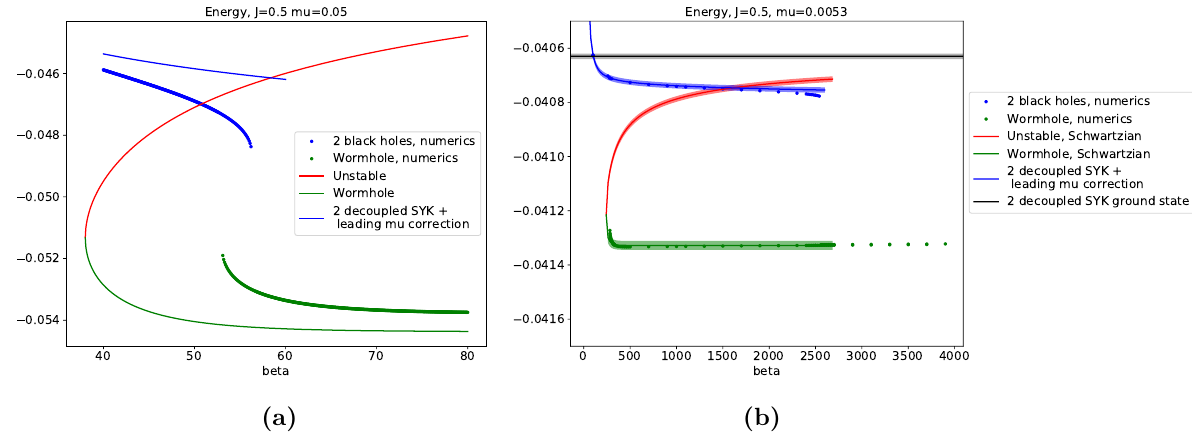
Figure 6 . Thermodynamics of the model for two different values of µ/J . In both J = 0 . 5 and in (a) µ = 0 . 05 and in (b) µ = 0 . 0053 . The dots correspond to numerical solutions of the SD equation. The blue ones for the two black hole phase and the green ones for the cold wormhole phase. The black line is the ground state energy of two decoupled SYK, 2 E (on the left plot it lies above 0 ,SY K the visible area). Blue curve: the perturbative result (2.19) for the energy. Green curve: wormhole branch of eq. (2.32). Red curve: unstable branch of eq. (2.32). The uncertainties, represented as shaded regions, come from the uncertainties in E and α . We see that in (b) the agreement 0 , SYK S is very good. However, in (a) the agreement is not so good, but the qualitative form of the curve is similar, if we joint the two end points of the dotted